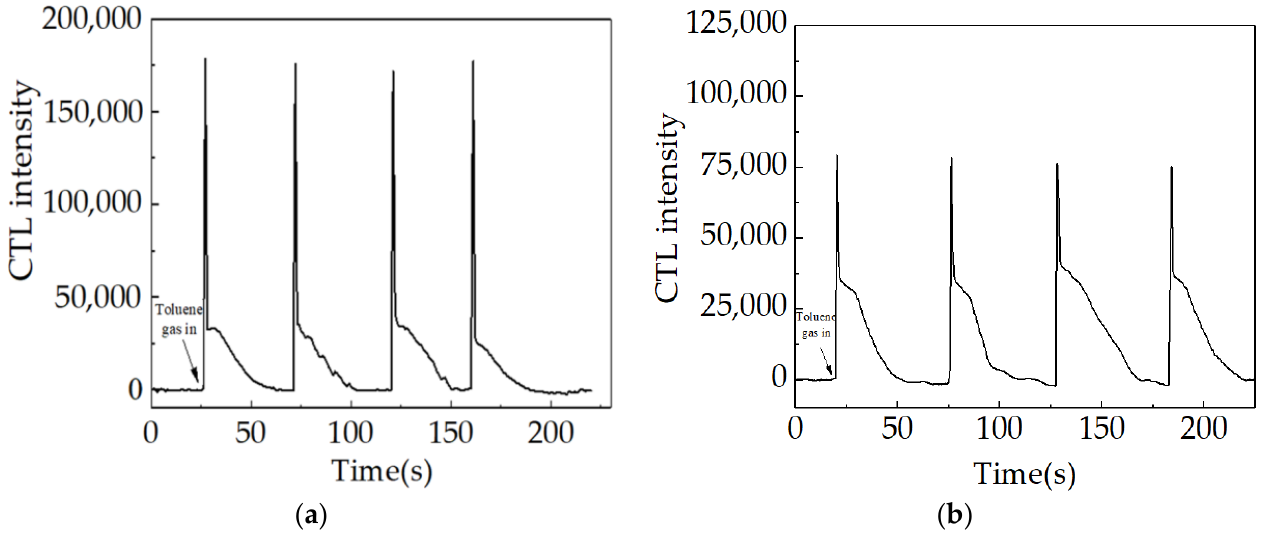
Figure 3. ( a ) The luminescence intensity upon exposure to toluene vapors of Pt/Ti 3 C 2 T x -CNT mate- rial; ( b ) the luminescence intensity upon exposure to toluene vapors of Ti 3 C 2 T x -CNT material. (de- tecting concentration: 87 ppm. Working temperature: 150 °C. Airflow rate: 200 mL/min).